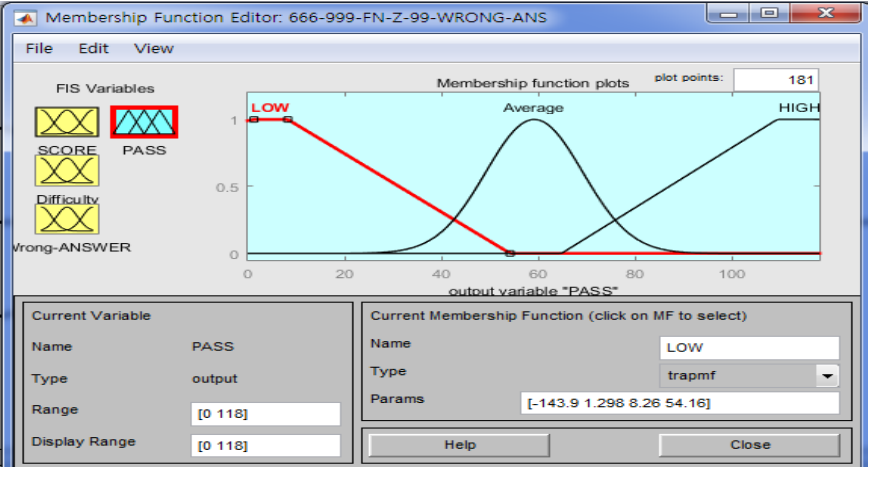
Figure 7. Automatic test question projection simulation.